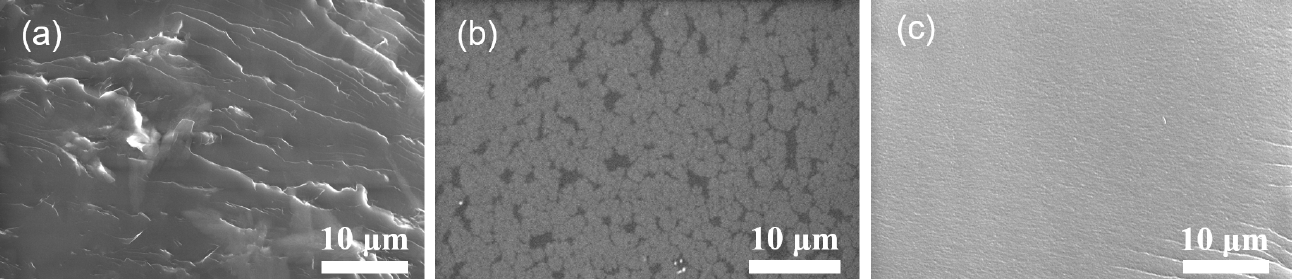
Figure 3. Cross-section SEM micrographs of the fracture surface morphology of ( a ) RL, ( b ) RL_G5, and ( c ) RL_G20 in 2500×